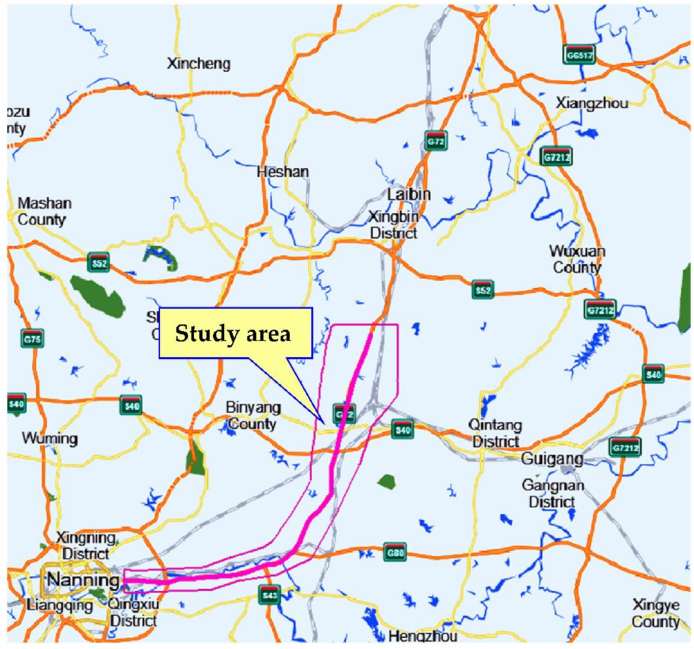
Figure 1. The location map of the study area.